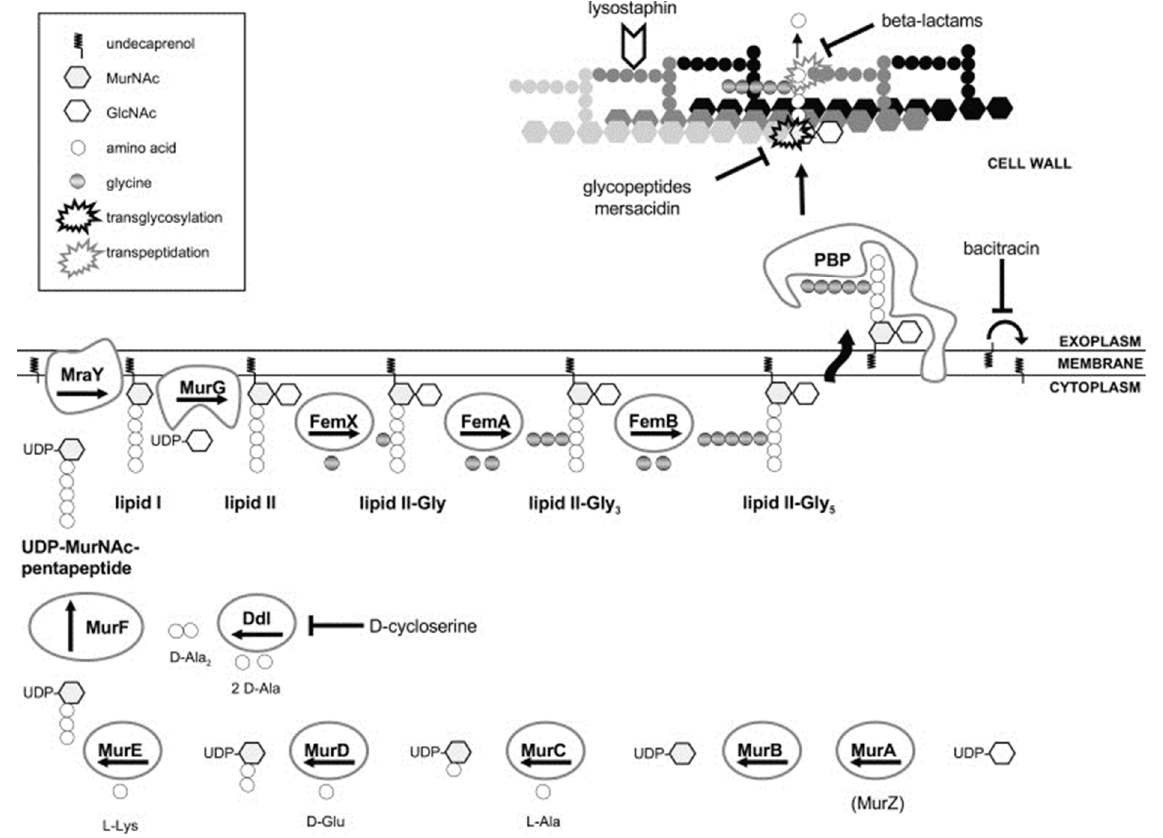
Figure 3. Schematic representation of the peptidoglycan synthesis and targets of cell wall active antibiotics in S. aureus . The inhibition of enzymatic activity is indicated by blocked arrows. UDP: uridine-diphosphate, MurNAc: N -acetylmuramic acid, GlcNAc: N ‐ acetylglucosamine. Adapted from reference [132] with the publisher’s permission.